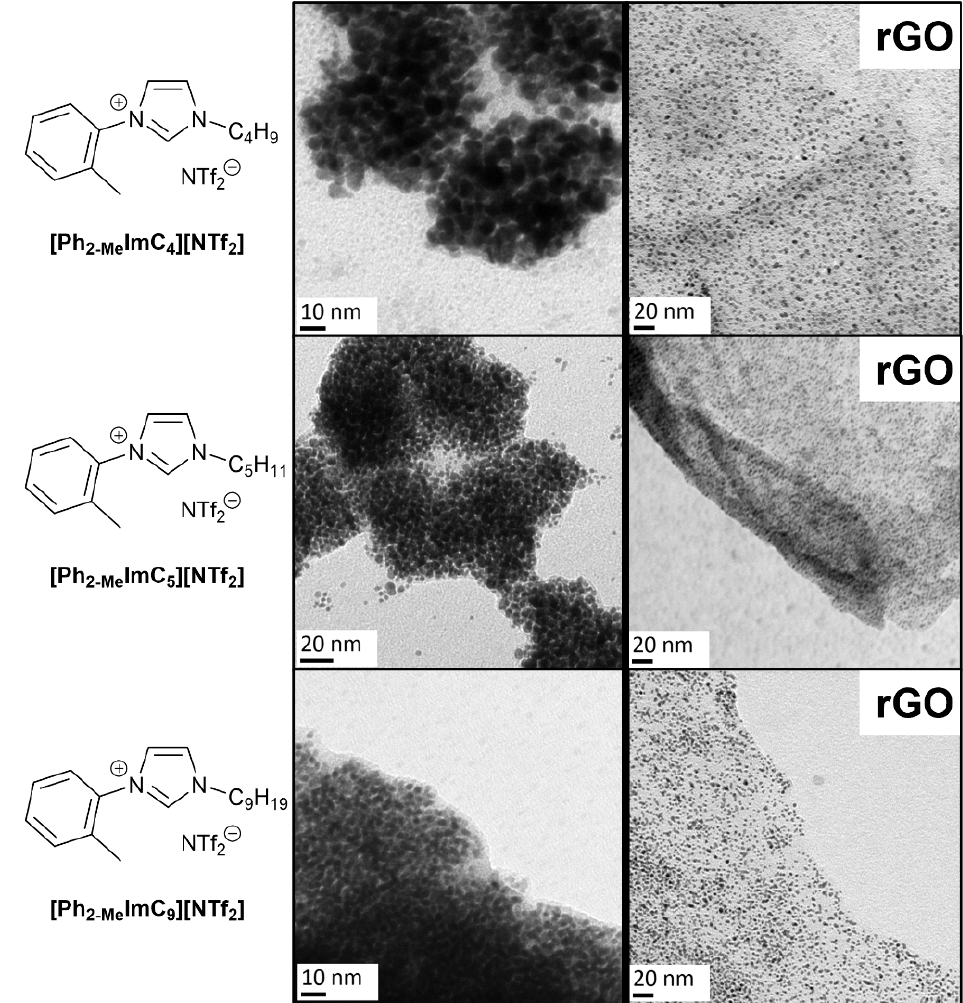
Figure 3. TEM images of Pt-NPs and Pt-NP@rGO composites obtained in the TAAILs (from top to bottom): [Ph 2-Me ImC 4 ][NTf 2 ] ( MP4-1, MP4_rGO-1/1 ); [Ph 2-Me ImC 5 ][NTf 2 ] ( MP5-1, MP5_rGO-2/1 ); [Ph 2-Me ImC 9 ][NTf 2 ] ( MP9-1, MP9_rGO-1/0.5 ). TEM images for Pt-NPs are shown on the left and for